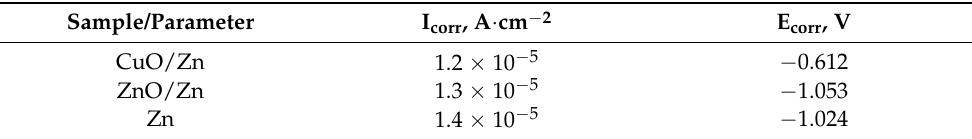
Figure 7. Potentiodynamic polarization measurements of ZnO/Zn, CuO/Zn, and ordinary Zn after 25 days’ immersion in the model corrosive medium of 5% NaCl. The electrochemical parameters are shown in Table 2. Table 2. Some important electrochemical parameters obtained from the potentiodynamic polarization measurements after 25 days’ immersion in the model corrosive medium (the presented values refer to a representative curve selected from investigations performed with a group of samples of a given species).